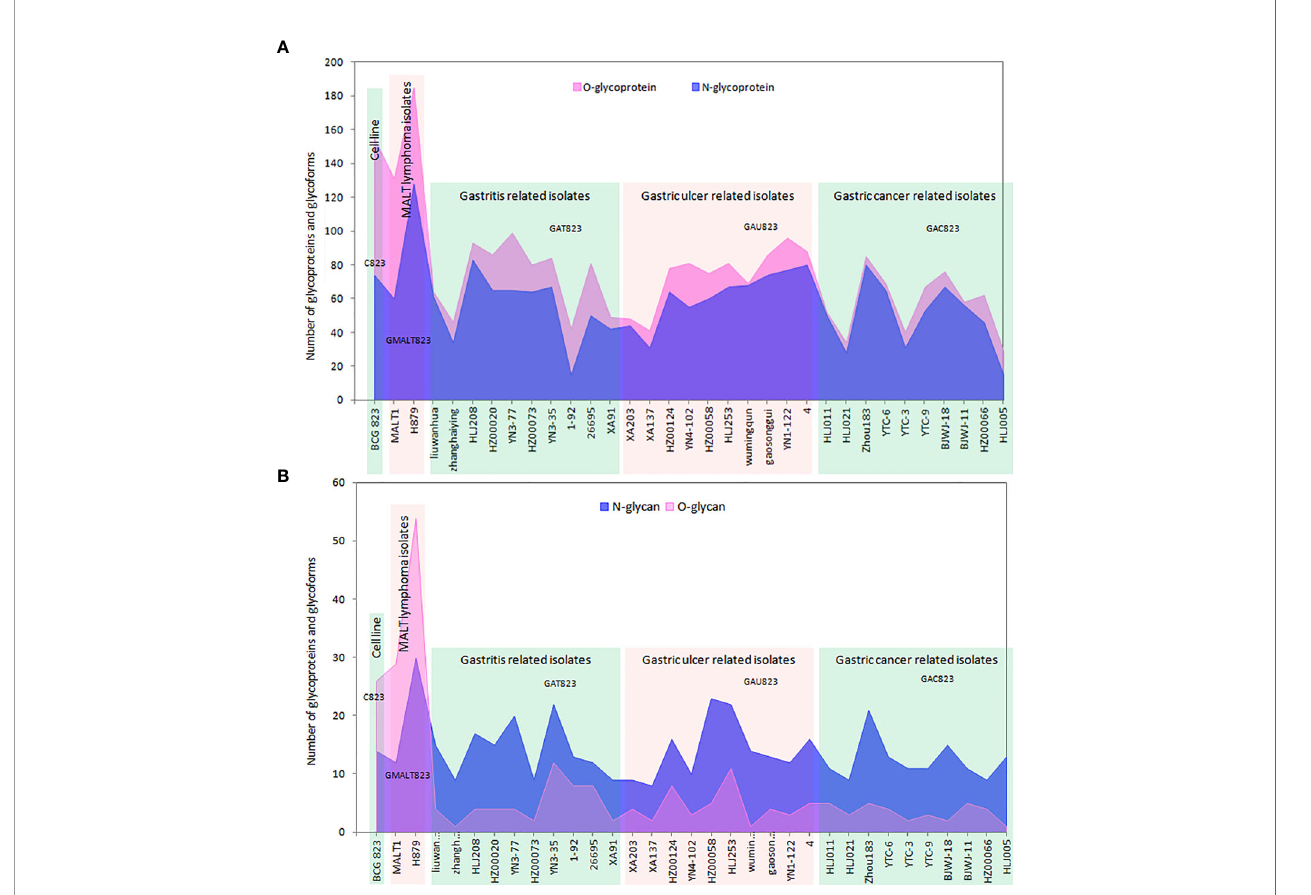
FIGURE 1 | Summary of the number of glycoproteins and glycoforms of all the samples used in this study. (A) The distribution of the numbers of glycoproteins; there are more O-glycans than N-glycans, and O-glycans are the dominant type of glycoprotein. (B) The distribution of the numbers of glycoforms; there are more O-glycans than N-glycans in C823 and GMALT823 cells, but in GAT823, GAU823 and GAC823 cells, the opposite is